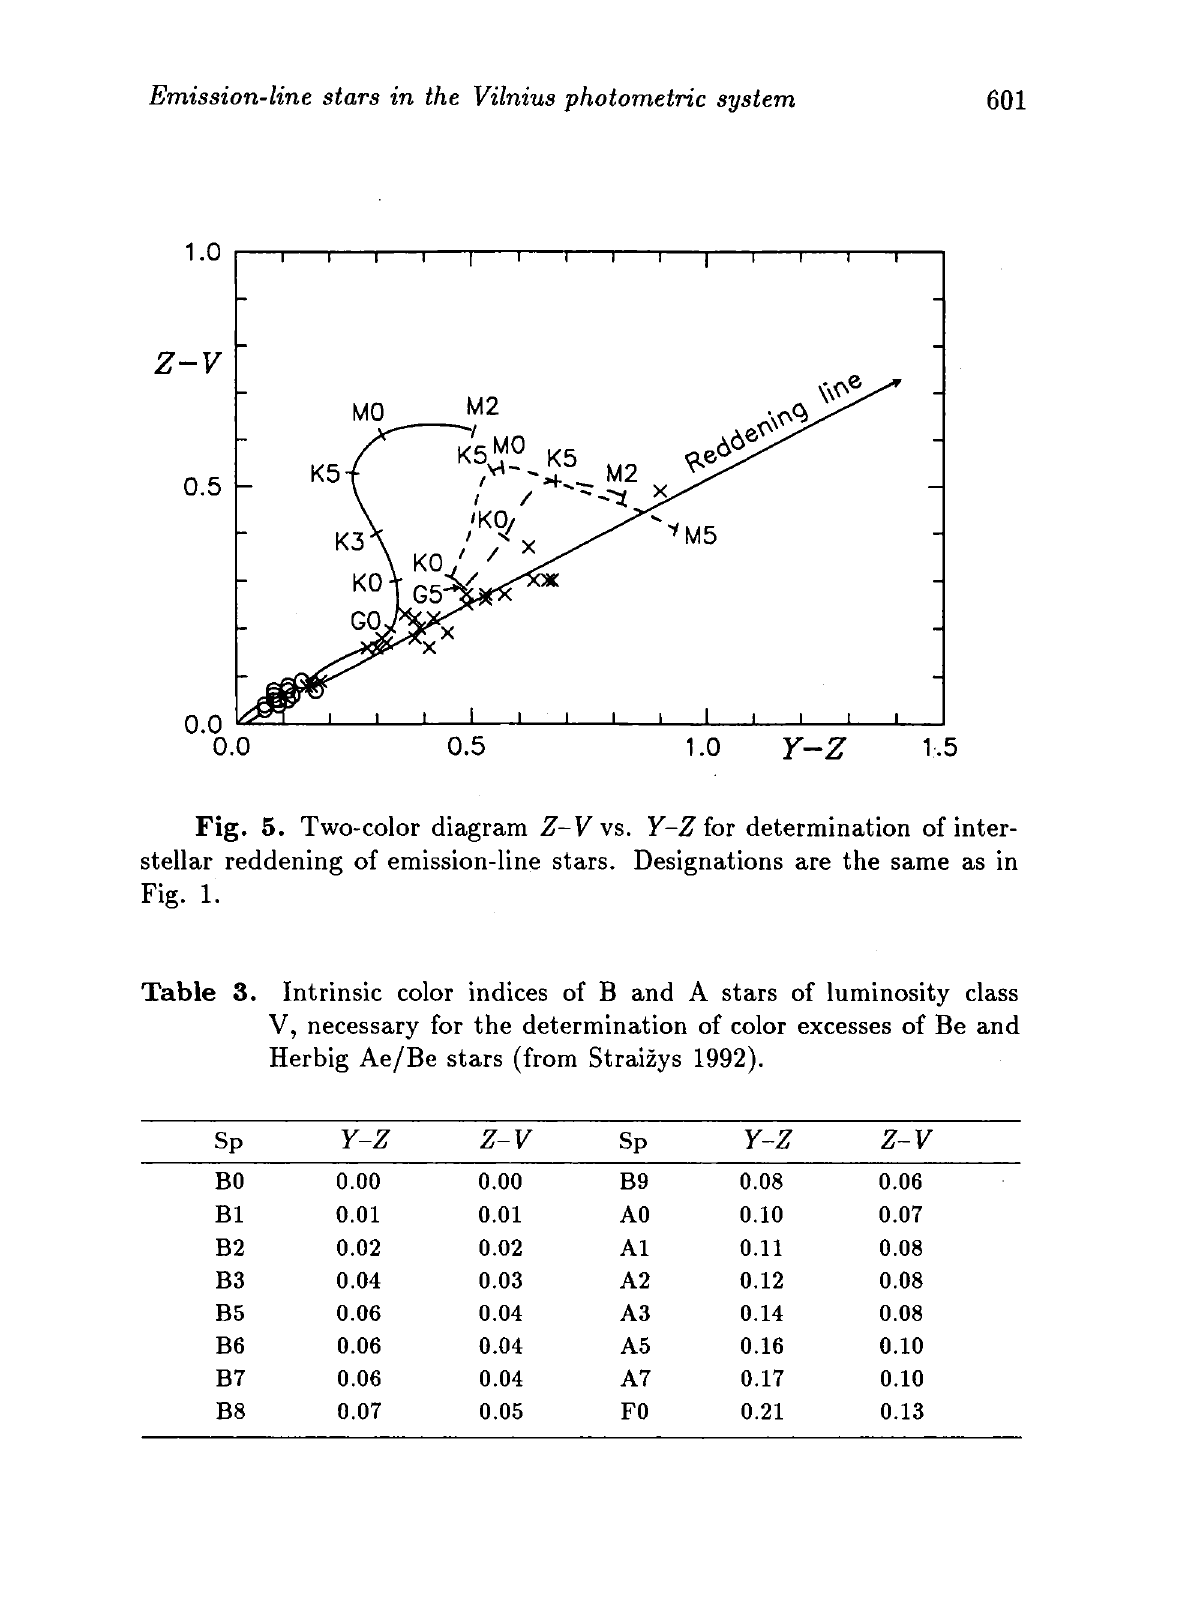
Fig. 5. Two-color diagram Z-V vs. Y-Z for determination of inter- stellar reddening of emission-line stars. Designations are the same as in Fig. 1.